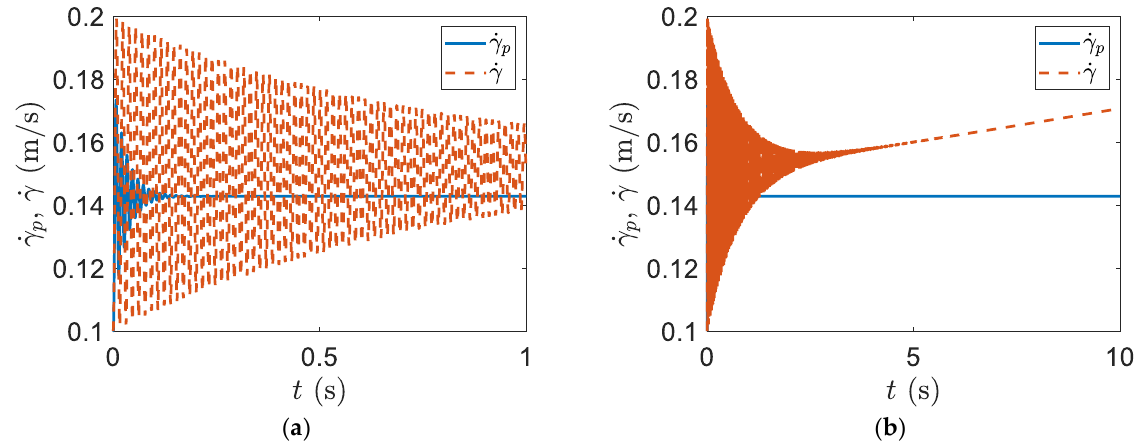
Figure 6. The smart blade system responses of the rotational velocity: (a) time interval (0, 1) s; (b) time interval (0, 10) s.